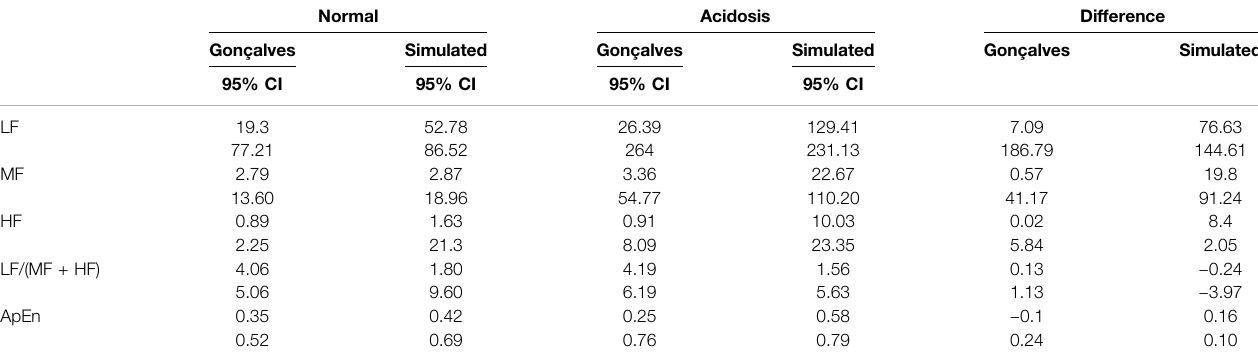
TABLE1| 95%Con fi denceintervals(CI)forthefHRVestimatesreportedbyGonçalvesetal.,95%CIofthesimulatedRRintervalsfHRV,andthedifferenceofthelimitsofthe 95% CI between the Normal and Acidosis